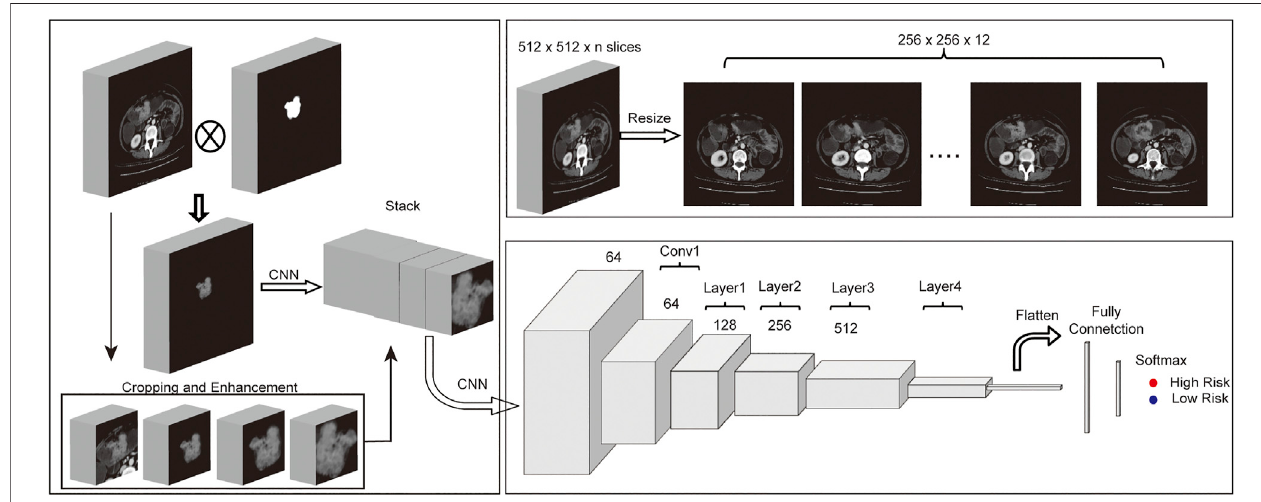
FIGURE 1 | Work fl ow of MSCNN. (A) Multi-Size based data enhancement of CT images before fed into MSCNN. (B) Data preprocessing of CT images with ROIs. (C) Network structure of MSCNN Multi-Size which includes a CNN to combine Multi-Size CT data, a ResNet34 network to extract image features of tumors from CT images and a last classi fi cation